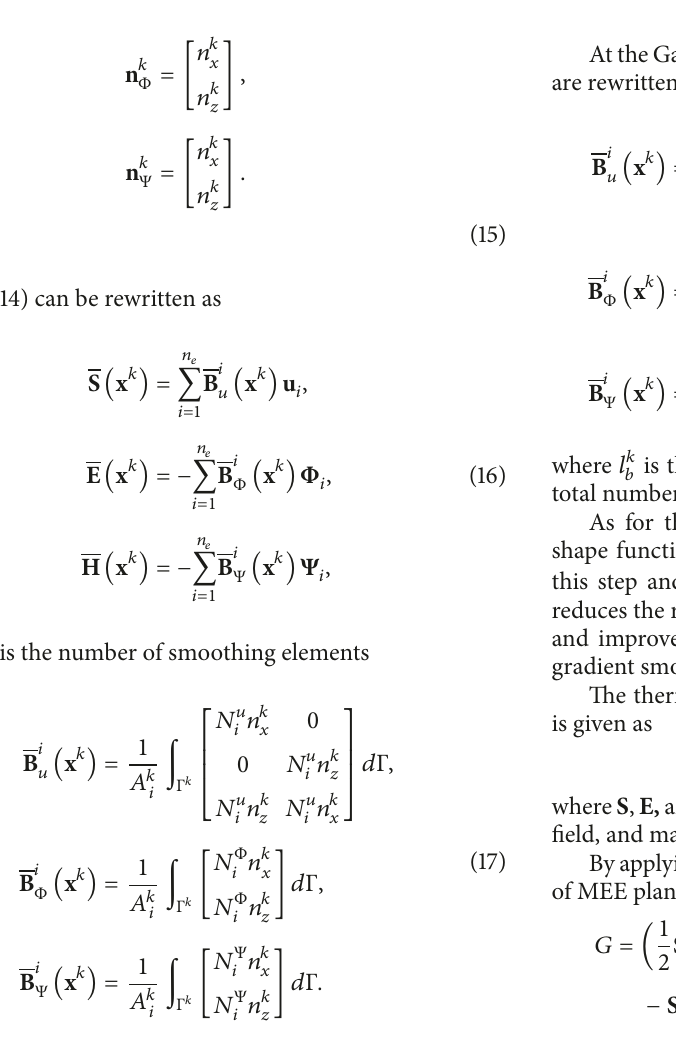
Figure 3: Smoothing subdomains and the values of shape